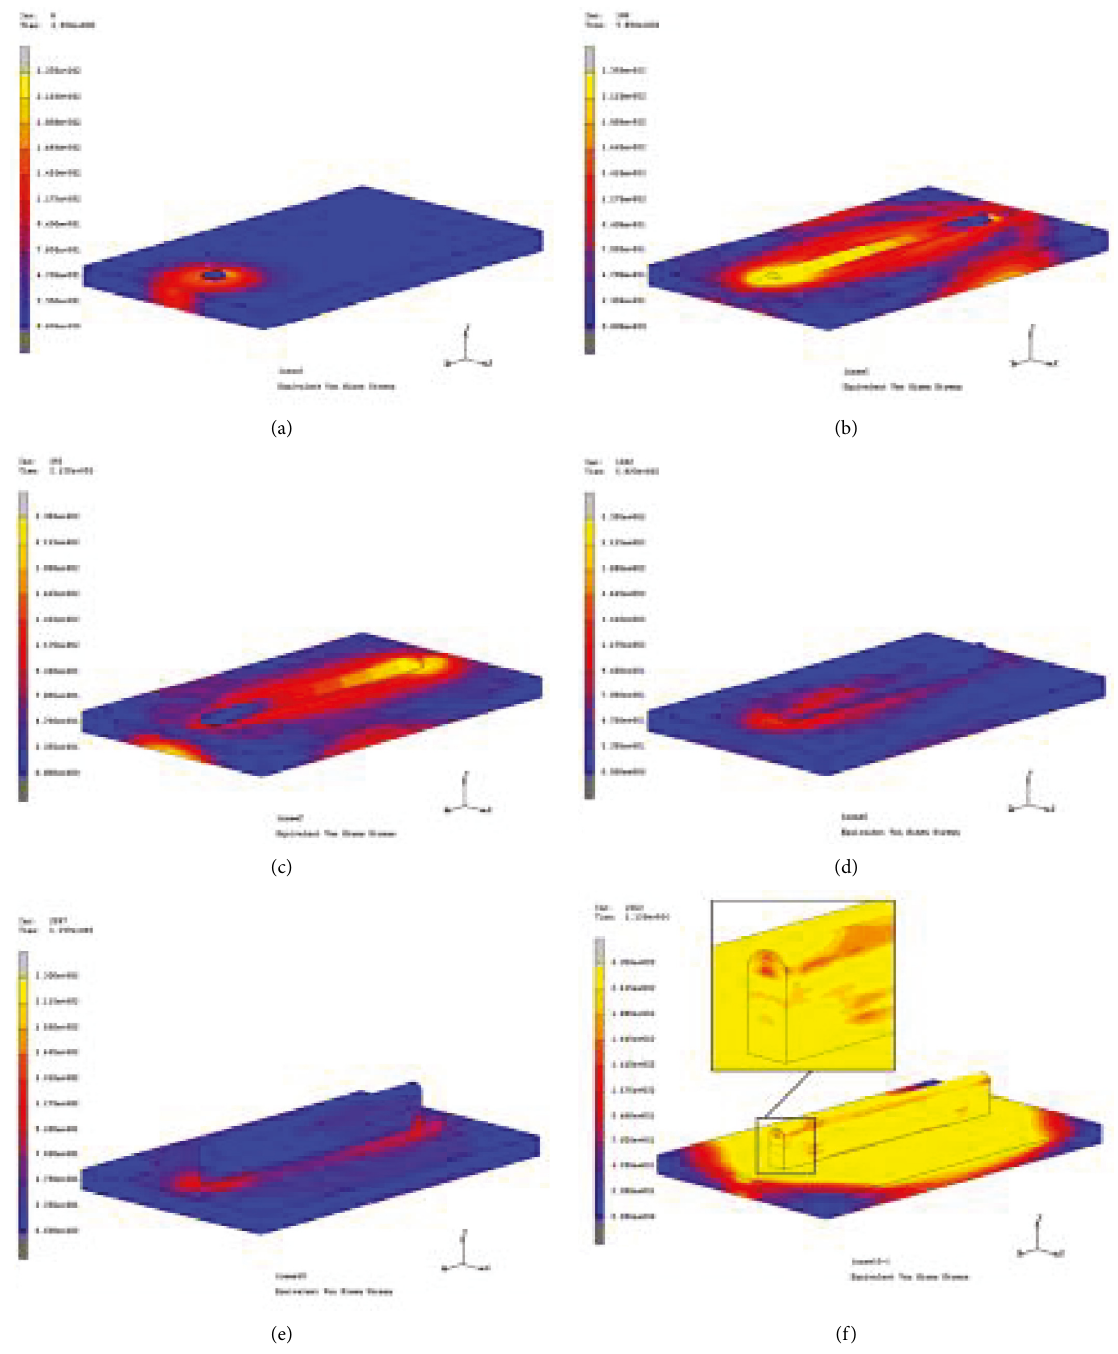
Figure 13: Stress evolution of ten-layer deposition component when heat source locates at (a) starting arc point of the 1st layer; (b) ending arc point of the 1st layer; (c) ending arc point of the 2nd layer; (d) ending arc point of the 5th layer; (e) ending arc point of the 10th layer; (f) when component cooling to room